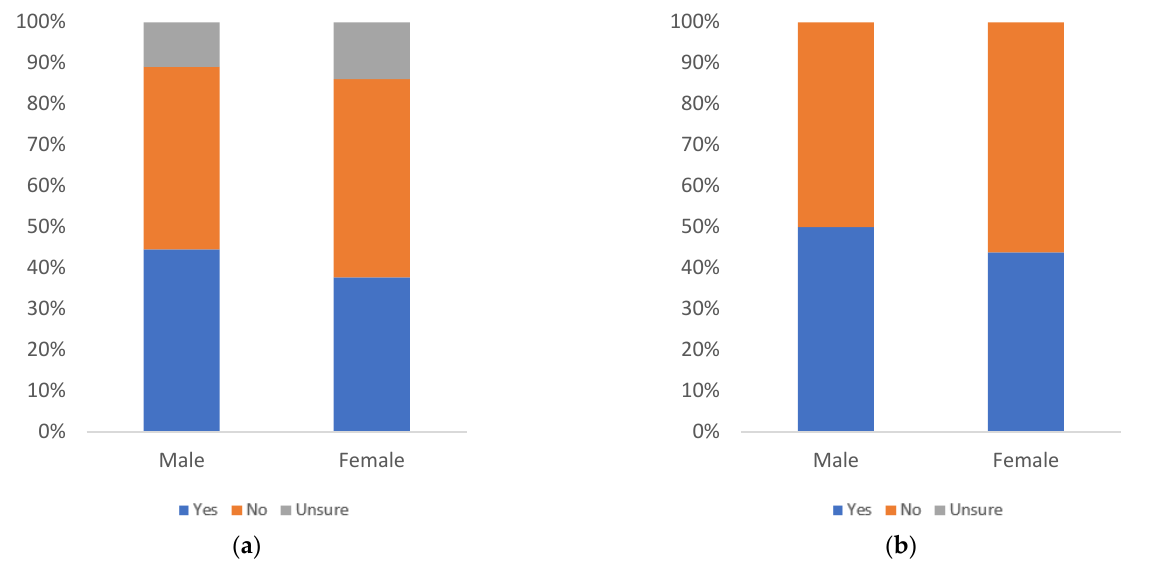
Figure 10. Label annoyingness, by gender: ( a ) with uncertain respondents (left) and ( b ) without uncertain respondents (right).